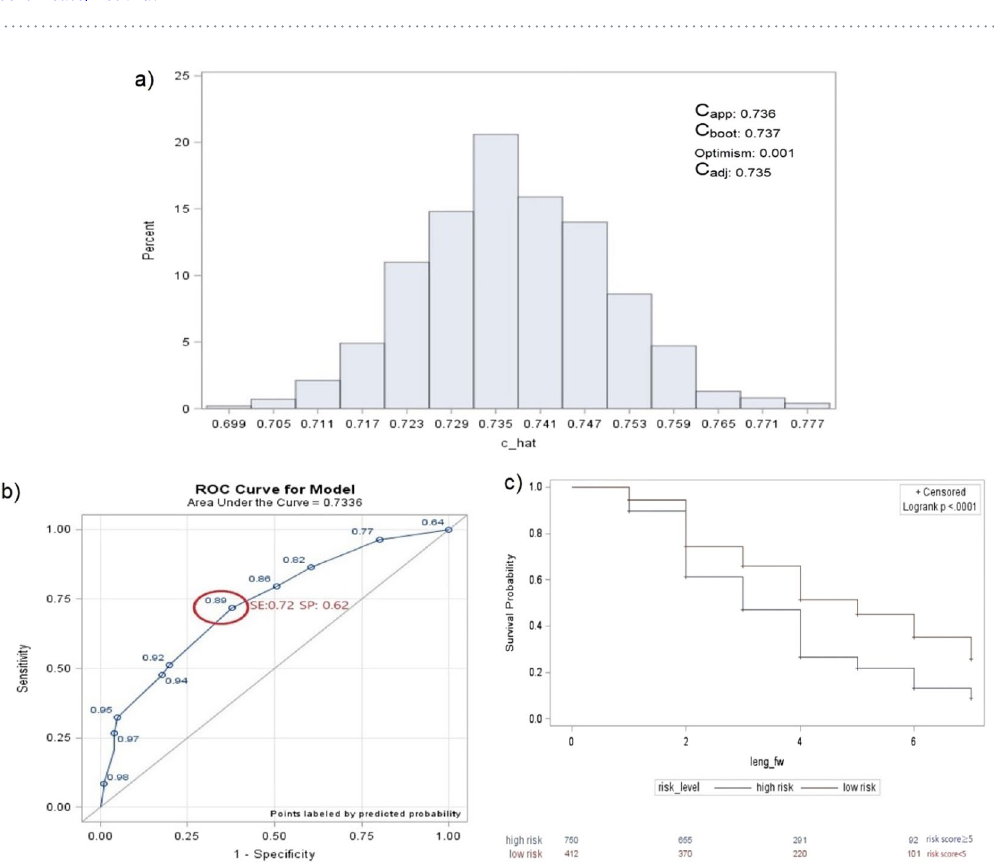
Figure 2. ( a ) C-index distribution of 1,000 bootstrap samplings. ( b ) Receiver operating characteristic (ROC) curve analysis using risk scores. ( c ) Comparison of survival estimates between the high- and low-risk groups based on risk scores. * ( a ) C app = c-index of the developed model (apparent discrimination); C boot = c-index of the developed models of the 1,000 bootstrap samples; C adj = C app − optimism (adjusted c-index). ** ( a )